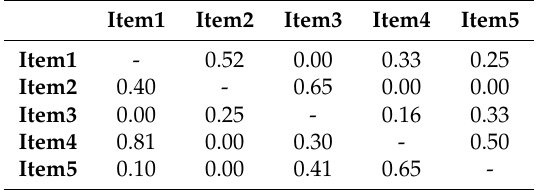
Table 3. Example of direct asymmetric similarities of items.